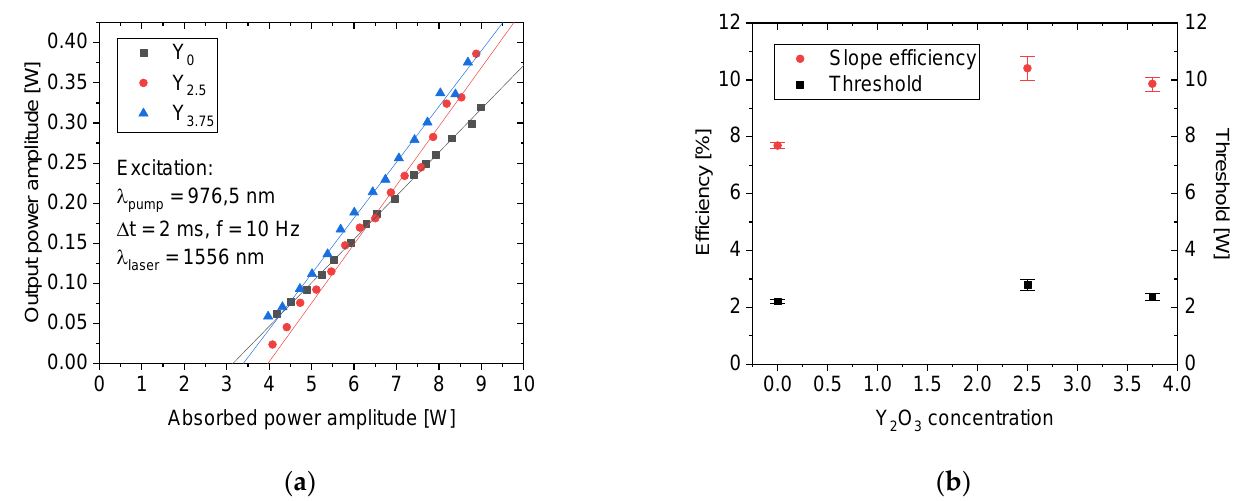
Figure 10. The laser performance of the investigated glasses. The laser output characteristics ( a ) and the laser slope efficiency and threshold in dependence on Y 2 O 3 concentration ( b ).